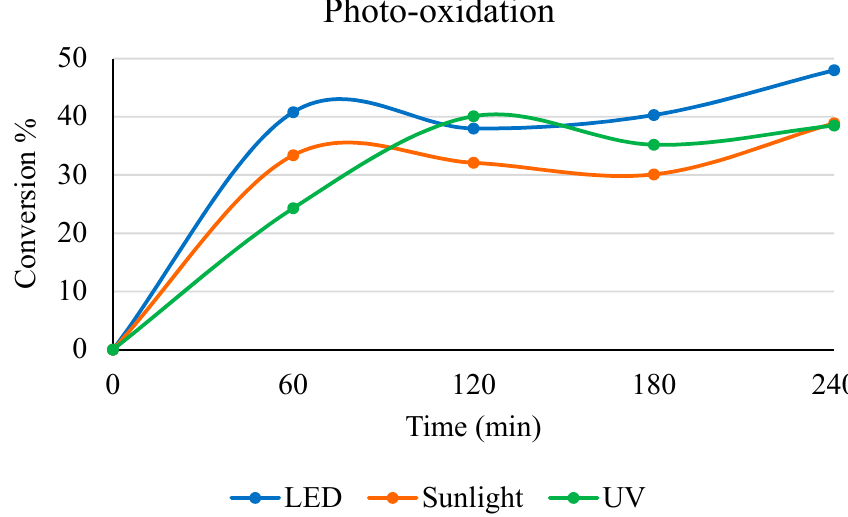
Figure 9. Photo-oxidation of NH 4+ with a 0.1% Ag/FSP catalyst under sunlight, UV and visible LED irradiation using 0.01 mol of NH 4 Cl, 0.2 g of photocatalyst, 40 mL/min of air flow, pH 5, r.t. and 250 mL of solution.